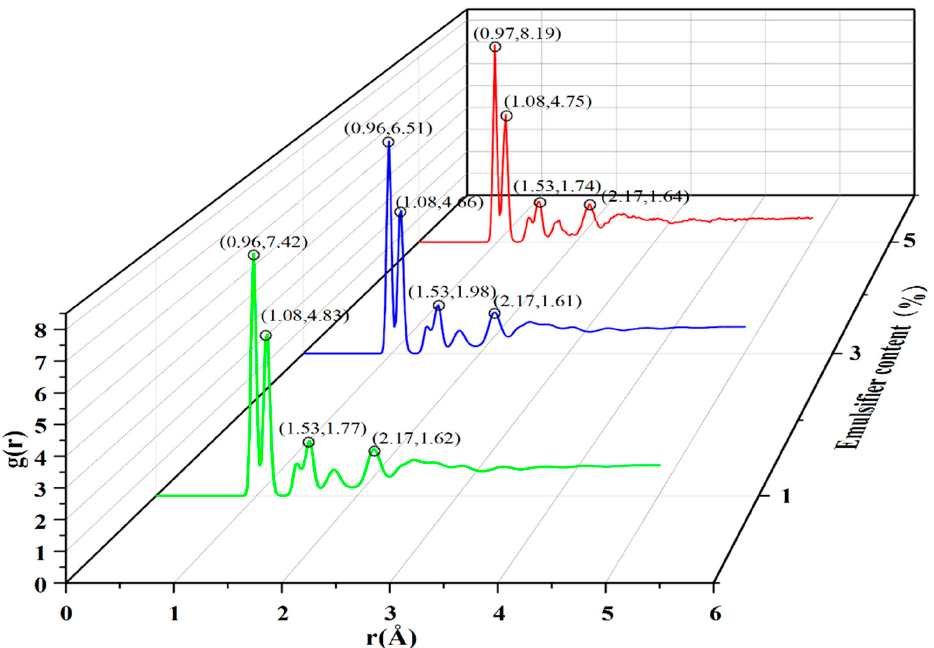
Figure 3. Radial distribution function of asphalt/water emulsion with different emulsifier contents.